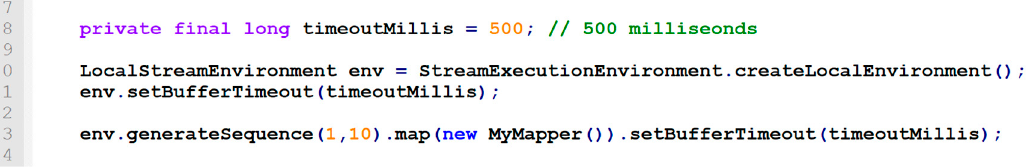
Figure 5. Generating the sequence and transferring it between machines using 500 ms as buffer timeout.